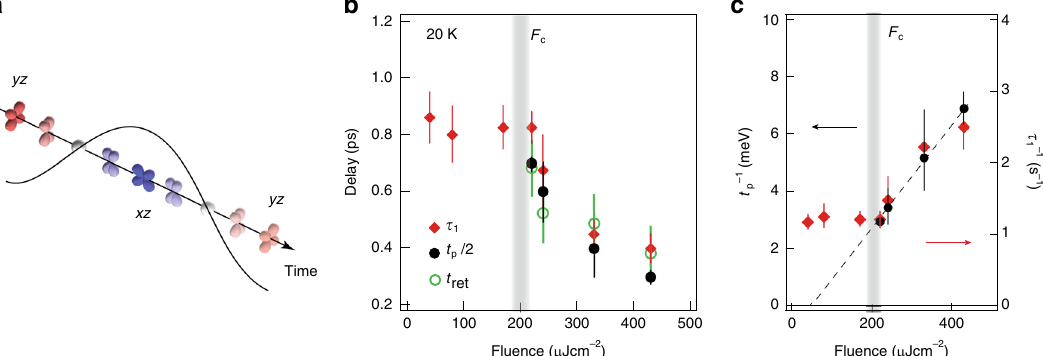
Fig. 4 Pump- fl uence dependence of the time scales for the orbital and nematicity dynamics. a Illustration of the orbital excitation in FeSe. b F dependences of t ret (open green circles), t p /2 ( fi lled black circles) and τ 1 ( fi lled red diamonds). c t p − 1 ( fi lled black circles) and τ 1 − 1 ( fi lled red diamonds) plotted as functions of F . The dotted line is a linear function derived from the data at F > F c Fluence-dependent dynamics of electronic nematicity . Here we decrease above F > F c . The time scale of the Fermi surface summarize the dynamics of the electronic nematicity in Fig. 4b. oscillation indicated by t p /2, which only appears in F > F c , also rapidly decreases from 700 to 300 fs as increasing F . It shows By fi tting Δ k F y ( t ) curves in Fig. 2d (Supplementary Note 6), we plot τ 1 and t p /2 for respective F . τ 1 is the exponential decay time that the oscillation gets more severely damped and hard to indicating the quick recovery of nematicity. It shows a constant observe at high F . We also overlay the time scale of the retarded value ( ∼ 800 fs) in the weak-excitation regime and a rapid maximum in xz component t ret . As a result, τ 1 , t p /2, and t ret NATURE COMMUNICATIONS| (2019) 10:1946